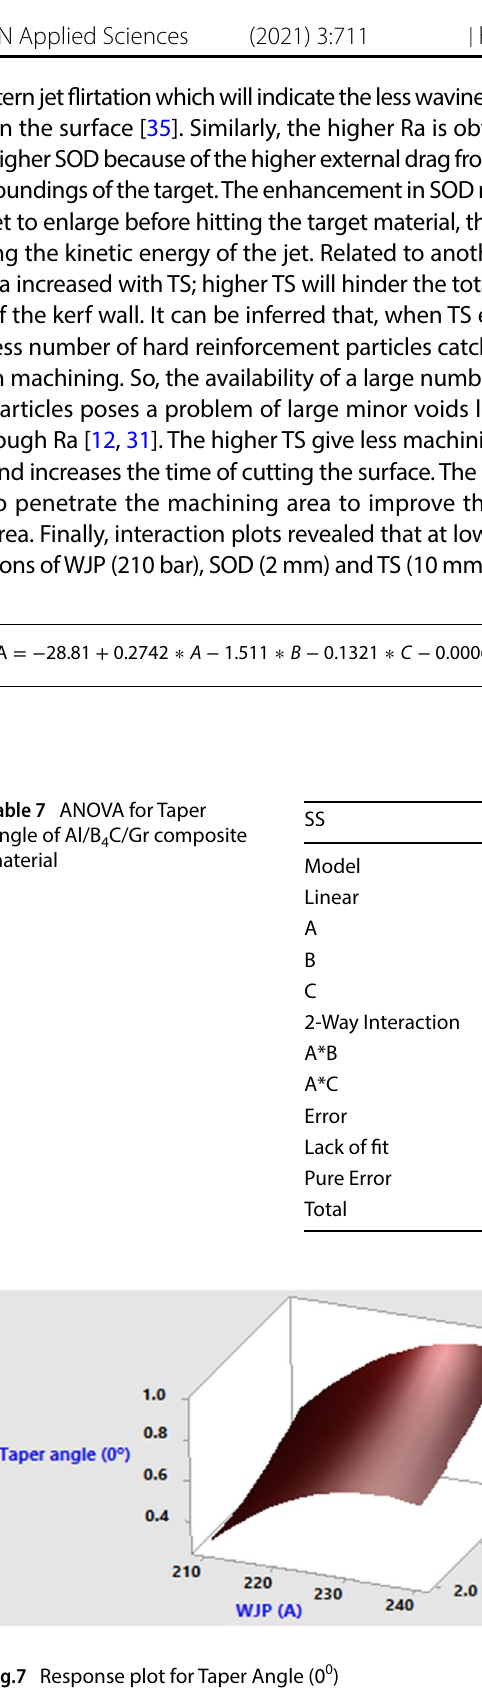
Fig.7 Response plot for Taper Angle (0 0